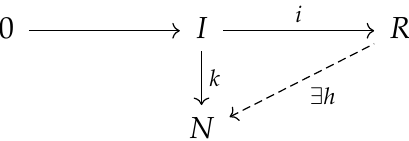
ϕ g Figure 2. Composition structure of a diagram for a normal projective R -hypermodule Proof. Similar to the proof of Theorem 2. Remark 3. An R-hypermodule M is called normal projective if it satisfies the equivalent condi- tions ( i ) and ( ii ) of Theorem 3, where the first one is equivalent with the notion defined in Definition 13, while the second one is exactly the definition given in [16] (see Definition 9). We conclude this section with a different characterization of normal injective R - hypermodules. One of the most commonly used equivalence of the axiom of choice is Zorn 0 s lemma . For a partially ordered set (called also poset) P , a chain in P is a nonempty subset S of P such that S is totally ordered, meaning that any two elements of S are comparable. Lemma 3. (Zorn’s lemma) If a poset P has the property that every chain in P has an upper bound, then P has a maximal element. Based on Zorn’s lemma, the following theorem provides another equivalent definition of a normal injective R -hypermodule, by considering R and an arbitrary hyperideal I of R as R -hypermodules (for further details, refer to [11]). Theorem 4. Let R be a hyperring and N be an R-hypermodule. Then the following statements are equivalent: